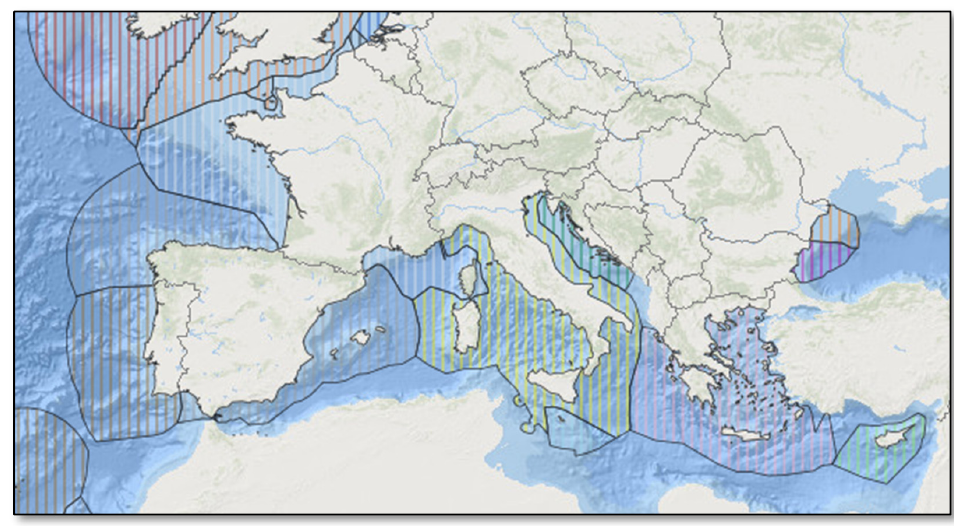
Figure 3. Borders of EU countries of the Mediterranean Sea from the view of the exclusive economic zones. Reproduced from https://emodnet.ec.europa.eu/en/map-week-%E2%80%93-exclusive-eco- nomic-zones (accessed on 8 May 2022)), with permission of EMODNET.